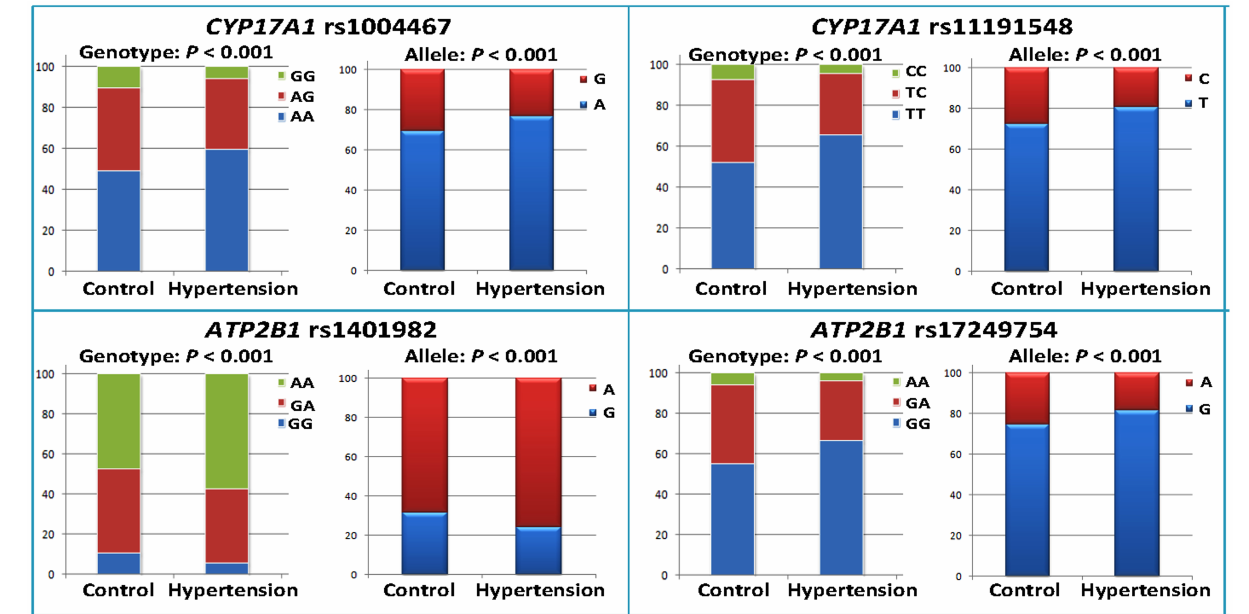
FIGURE 1 | Genotype and allele frequencies of the four CYP17A1 – ATP2B1 SNPs in the control and hypertension groups.